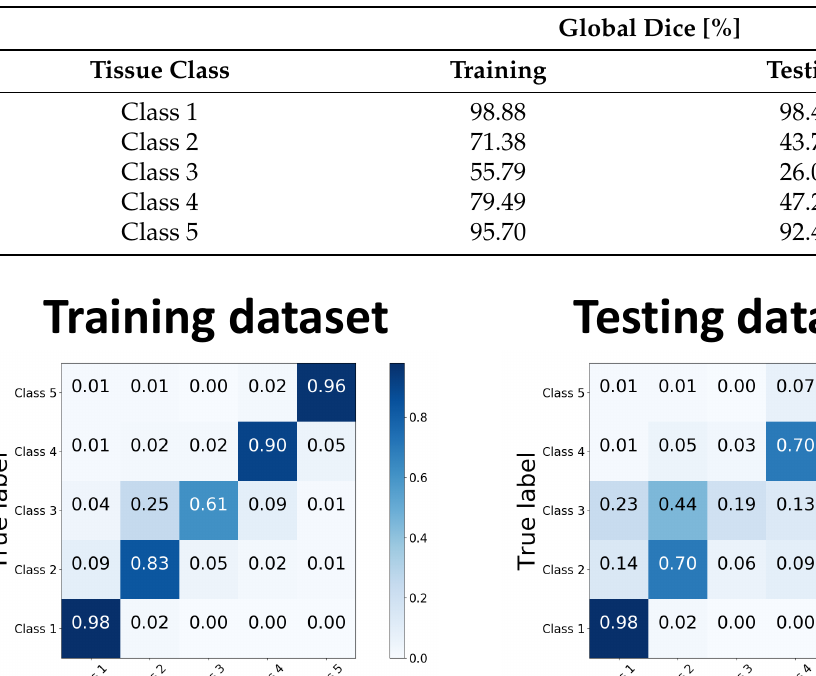
Table 6. Global Dice (in %) for ensemble of six networks on final data.